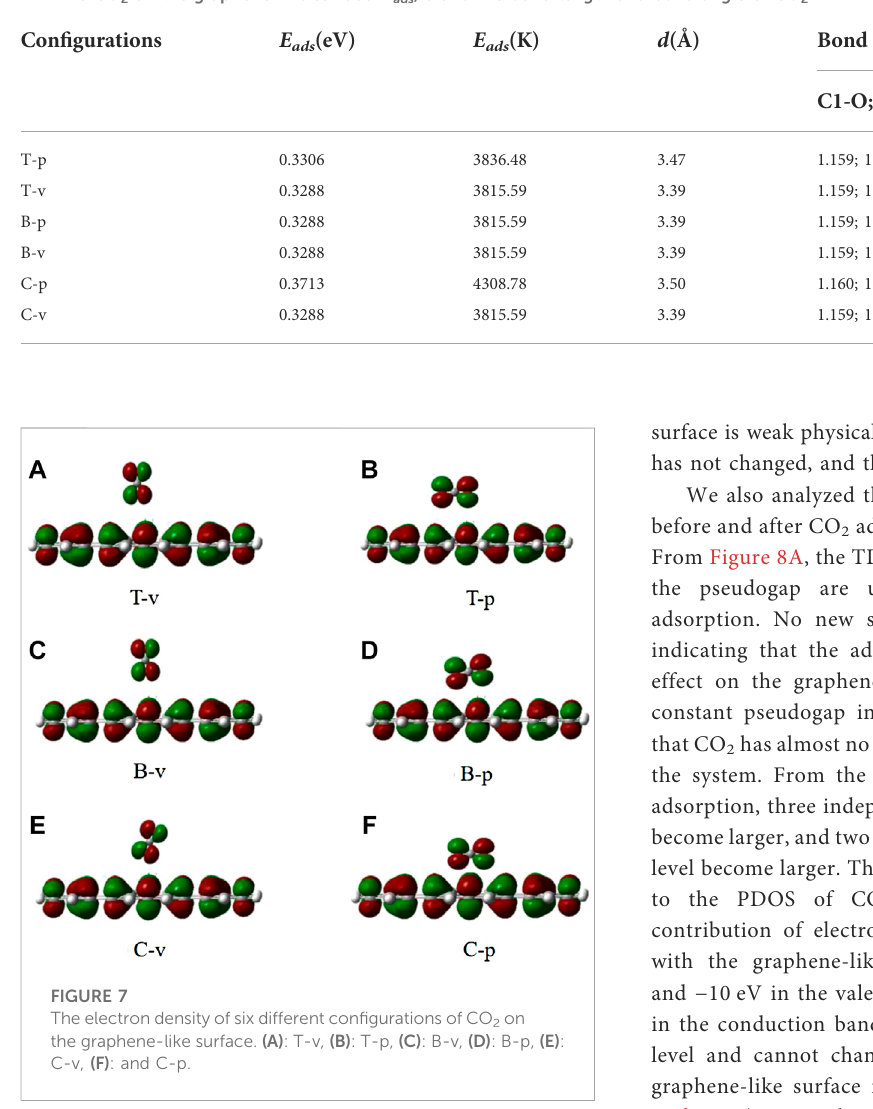
TABLE 3 CO 2 on the graphene-like surface: E ads , d and the bond length and bond angle of CO 2 .